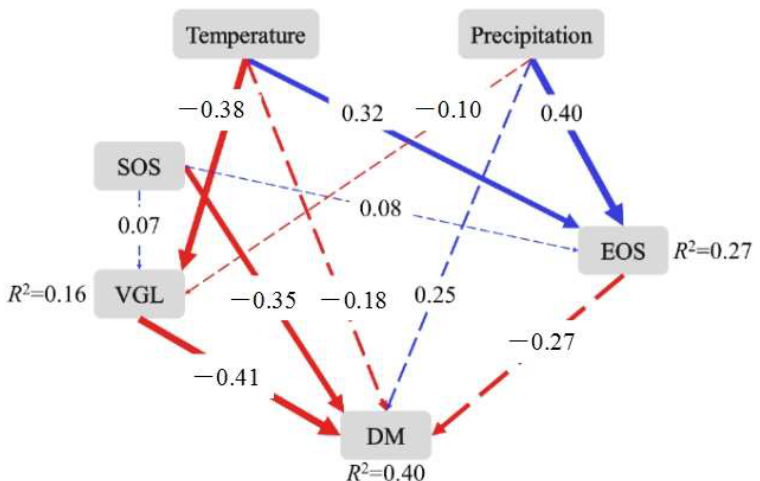
Figure 4. Effects of the start of the growing season (SOS) and the end of the growing season (EOS) on the plant production of Stipa krylovii . VGL represents vegetative growth length; DM represents dry mass. χ 2 = 3.27, df = 4, p = 0.51, AI = 49.27, RMSEA (root mean square error of approximation) <0.001. The red and blue arrows indicate negative and positive correlations, respectively, and arrow thickness represents the strength of correlation. The solid and dotted lines indicate significant ( p < 0.05) and insignificant effects ( p > 0.05), respectively. Values on the arrows indicate standardized path coefficients. The R 2 values next to the response variables represent the proportion of variation explained by relationships with other variables.